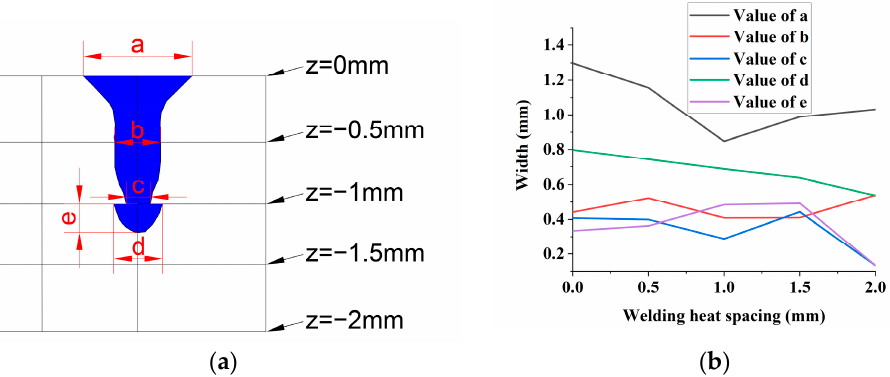
Figure 5. The size of the molten pool at the cross-section of the second weld seam at different weld spacing. ( a ) Measurement location of the molten pool; ( b ) dimension of the molten pool.